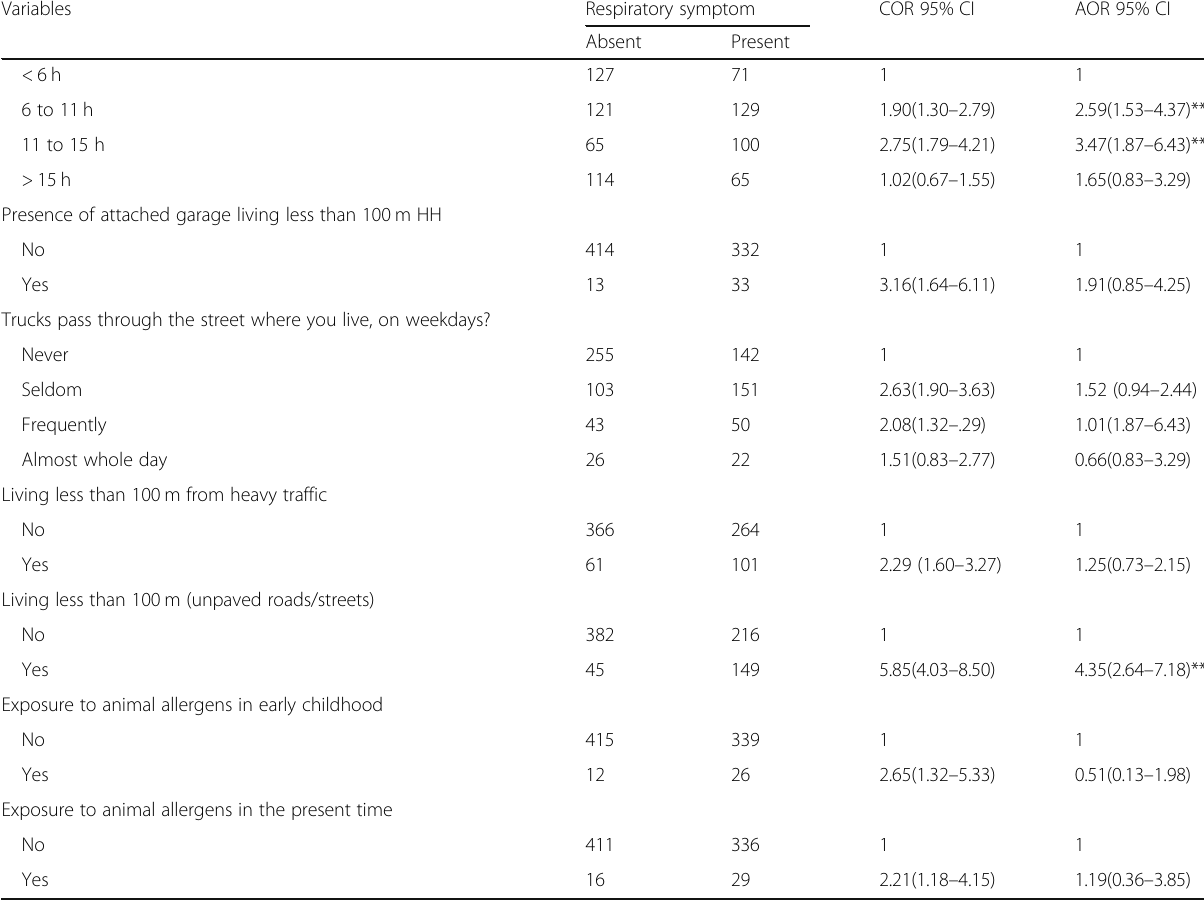
Table 3 Factors associated with mothers ’ respiratory symptoms in Gondar city northwest Ethiopia, 2019